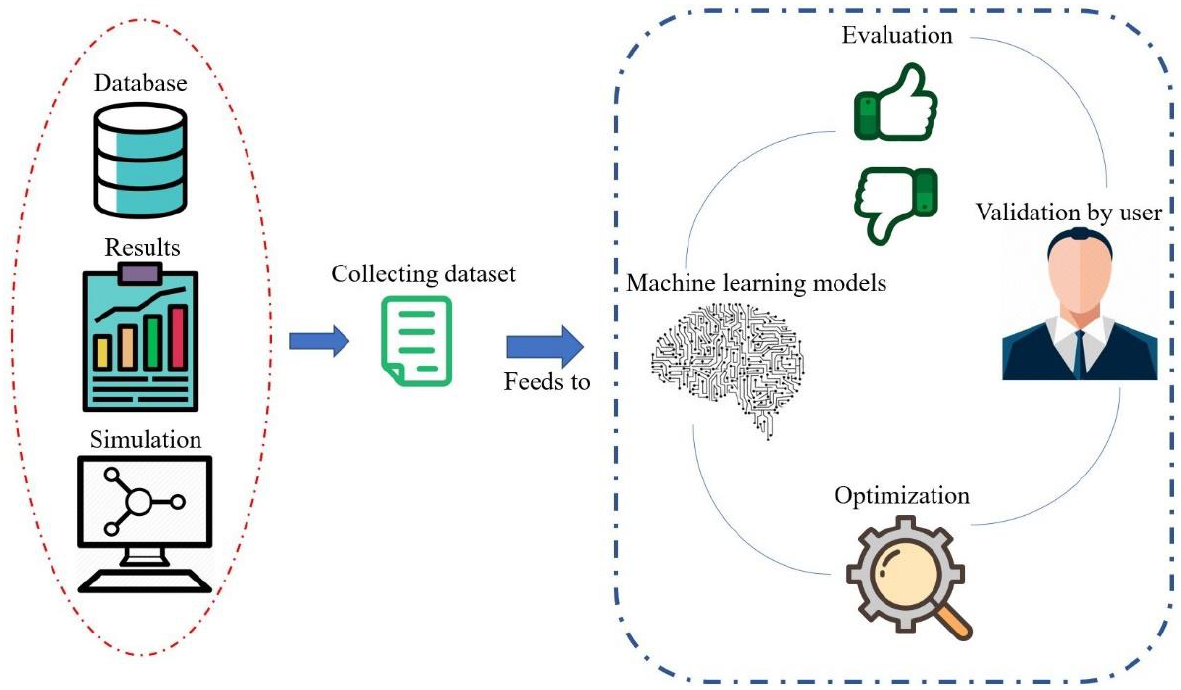
Figure 1. A general framework of the machine learning approach.